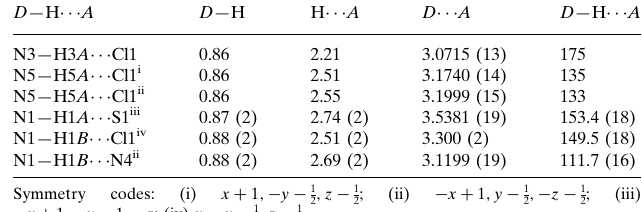
Hydrogen-bond geometry (A˚ , (cid:3)